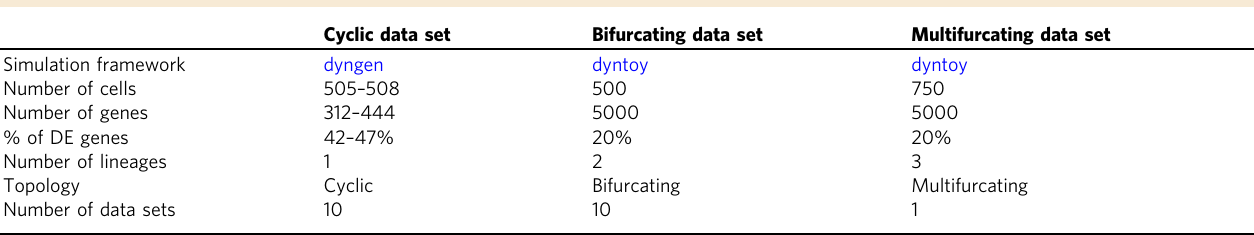
Table 1 Overview of simulated data